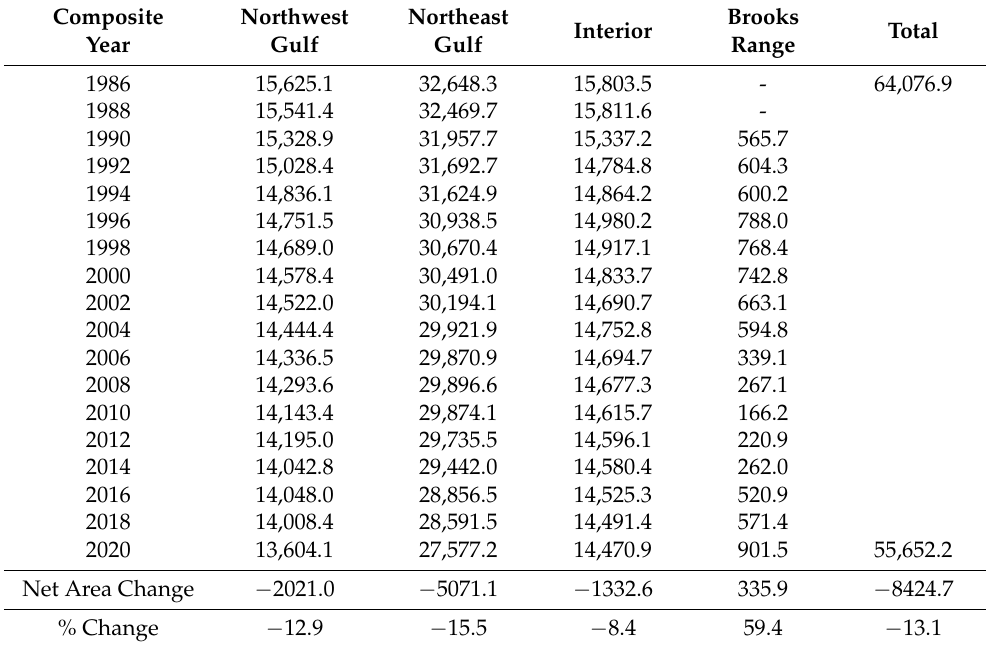
Table A1. Overall glacier-covered area for biannual composites for aggregated climate divisions. Note that areas for the Brooks Range are excluded from total areas and percentage changes due to higher uncertainty in this region. Areas are km 2 .